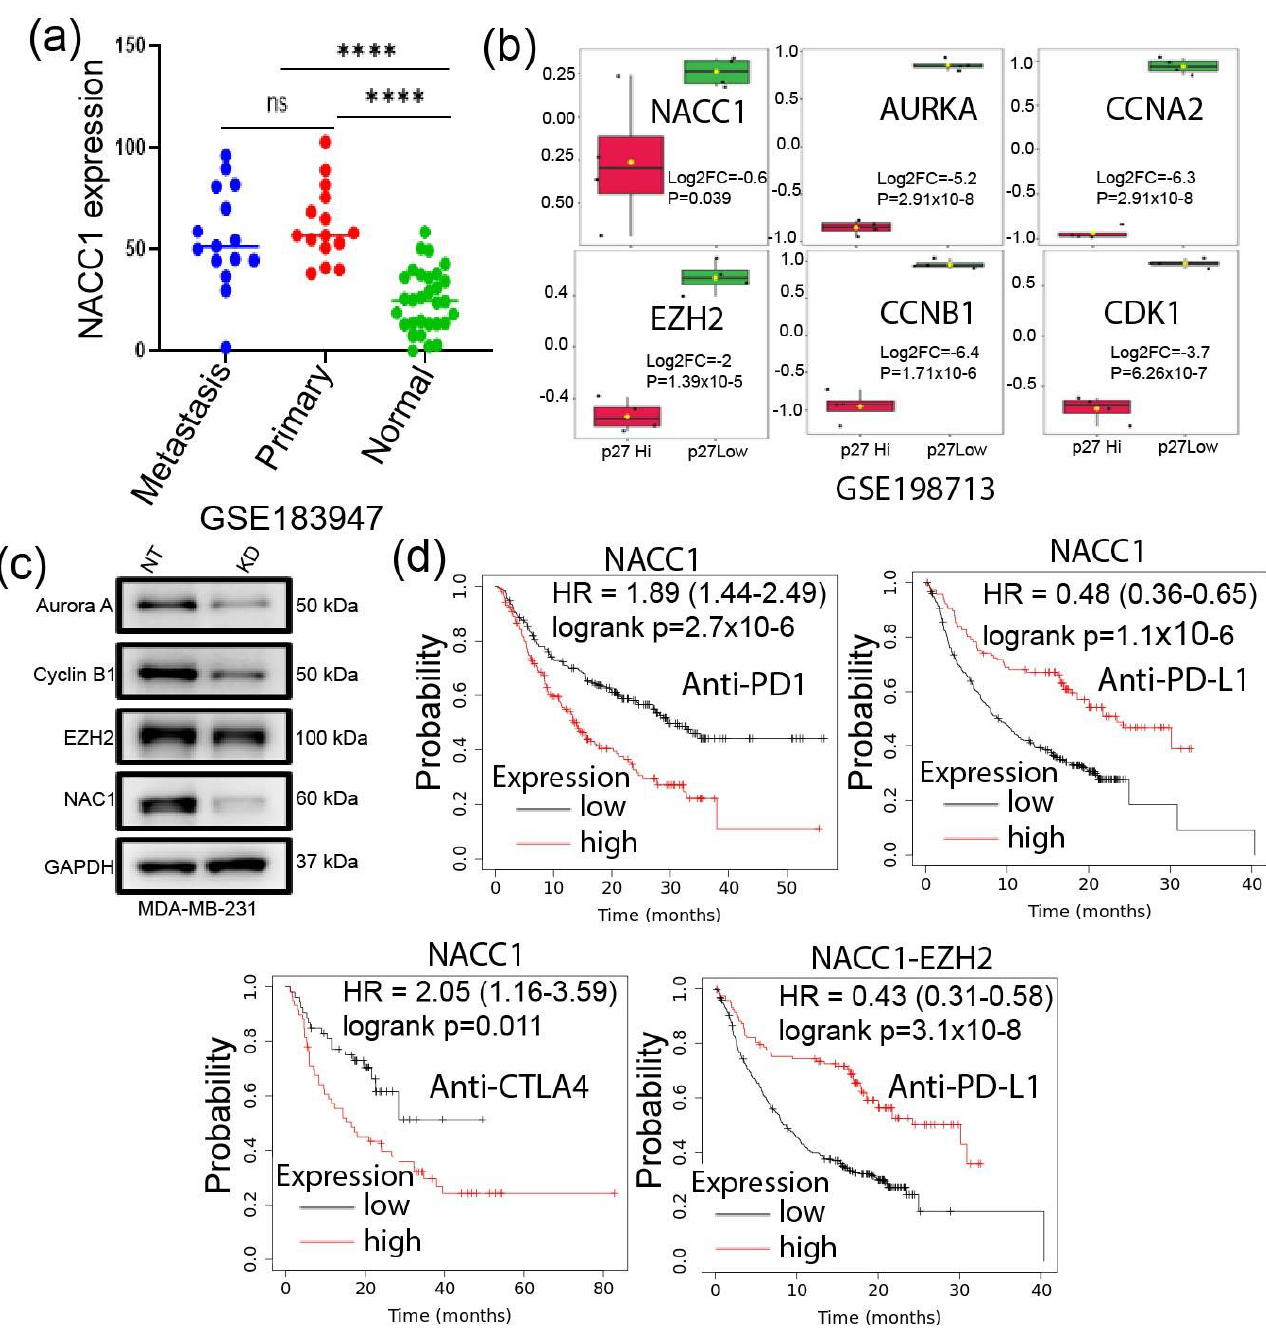
Figure 7. NACC1 depletion reduces the expression of the SGs, and a combination of NACC1 with EZH2 provides a better prognosis for patients under ICIs therapy. ( a ) NACC1 expression in the matched normal, primary, and metastasis TNBC samples( p ≤ 0.0001—****, ns-not significant); ( b ) expression of the five genes in p27 high vs. p27 low samples of GSE198713 datasets; each dots rep- resent a sample, and bars represent median values with range ( c ) expression of Aurora A, Cyclin B1, and EZH2 in TNBCs cells subjected to depletion of NAC1; and ( d ) overall survival analysis of patients under ICIs treatment in relation to SGs and NACC1 expression.